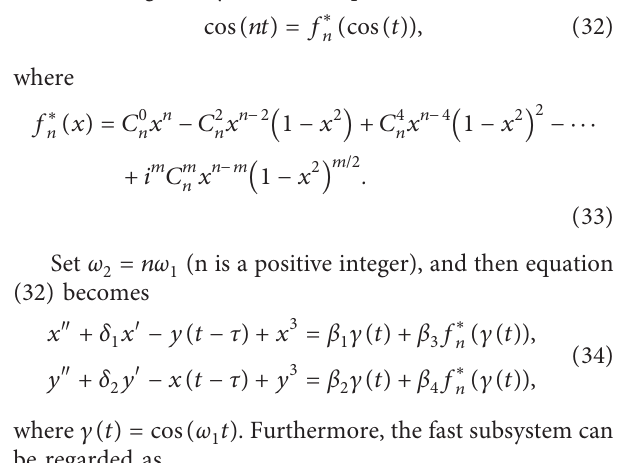
Figure 7: The time history of fast-slow system (1) at ω where the parameters are a � b � 1 , α � 0 . 1 , ω τ � 0 . 3, and f